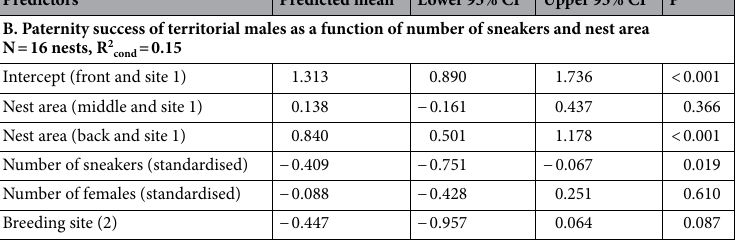
Table 4. Statistical analysis: paternity success distribution. Generalized linear mixed model with number of eggs fertilized by territorial and sneaker males as response variable. Predicted means and their credible intervals (CI) are based on a binomial distribution with logit-link in (see Materials and methods). For factorial predictors, estimates are computed using the indicated intercept level as reference. This choice is arbitrary and does not affect overall conclusions.